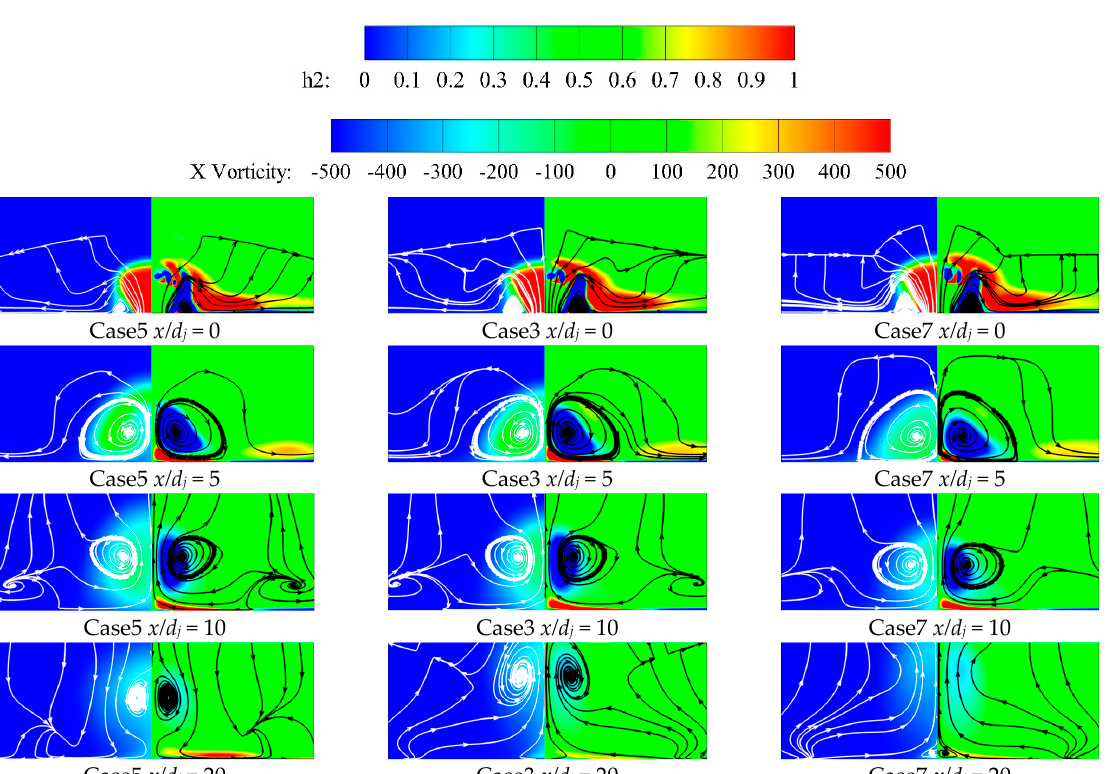
Figure 12. Q criterion iso-surface and x direction vorticity of each section. As for the impact of the angle of SWG change on hydrogen distribution and vorticity of each section, the flow field data near the lower wall fuel jet in Case3, Case5 and Case7 were extracted, as shown in Figure 13. The left side of the figure is the hydrogen mass fraction diagram, while the right is the x -direction vorticity diagram. With the increase in the angle of SWG, the intensity of the oblique shock wave increases, and the shock/jet shear layer effect becomes more apparent. At x/d j = 0, the horseshoe vortex area increases, and the region with higher vorticity is widely distributed. At x/d j = 5, hydrogen is mainly distributed in the high vorticity region, CVP enrolling and dominating the mixing. At x/d j = 10, the horseshoe vortex develops outward in the spreading direction and gradually moves away from the fuel core region. The distribution of hydrogen core breaks out of the limitation of the CVP structure. At x/d j = 20, the fuel distribution and vortex structure are uplifted with the increase in the angle of SWG.